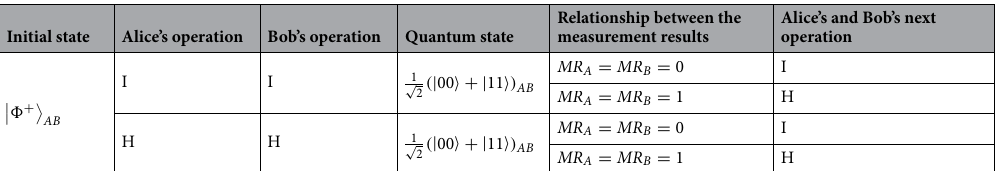
Table 2. Encoding and decoding table.